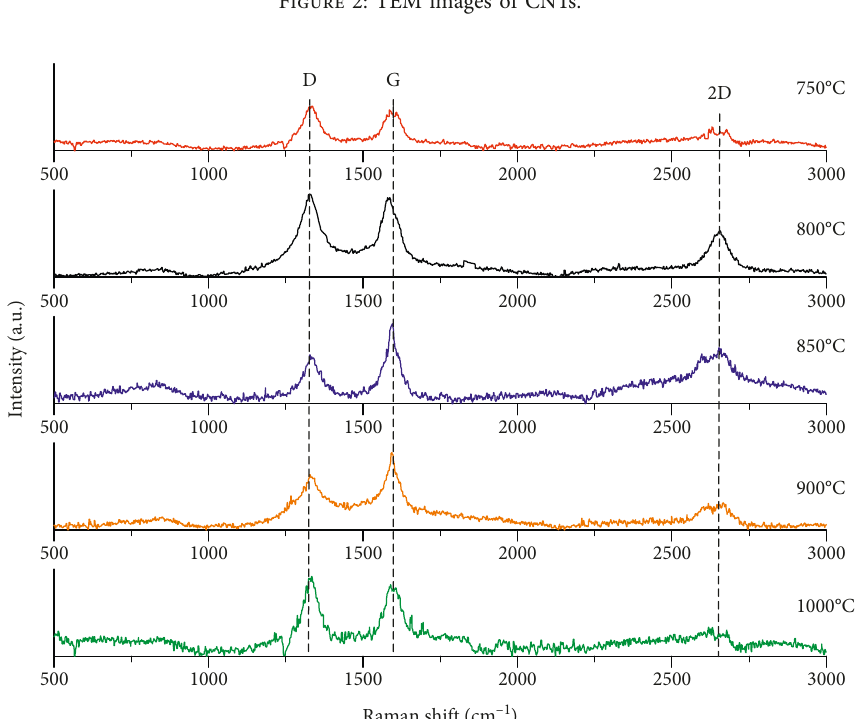
Figure 2: TEM images of CNTs.